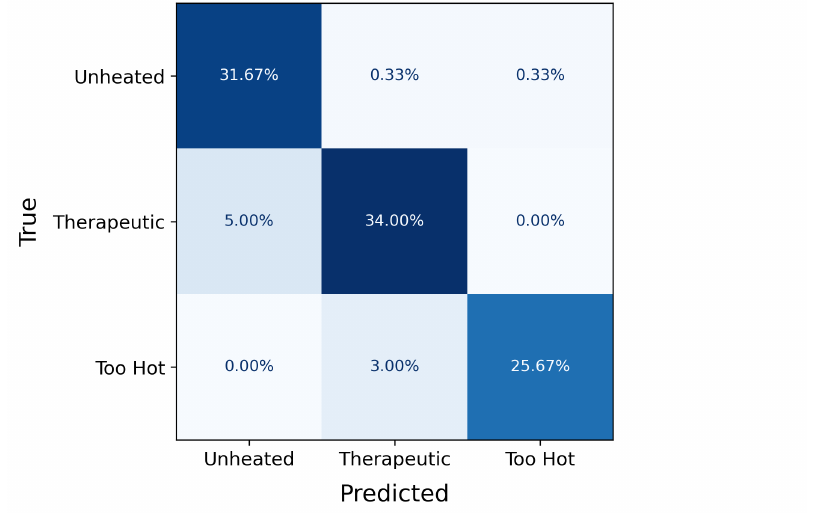
Figure 6. Confusion matrix for the validation samples of the tumor